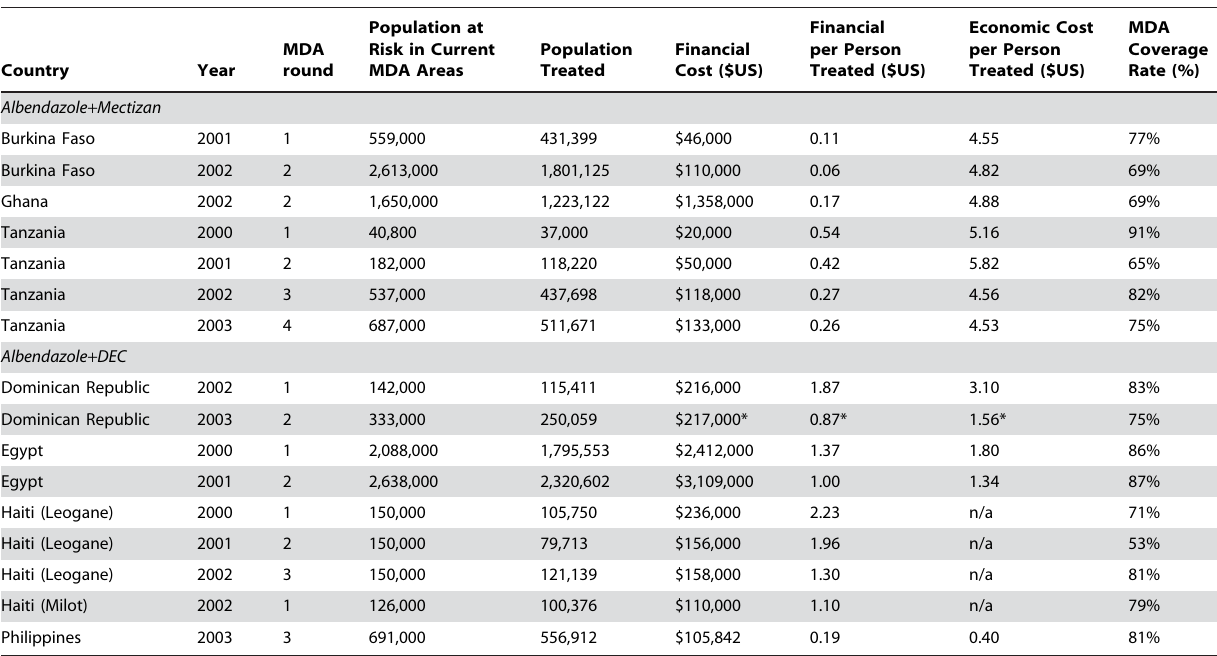
Table 4. Financial and Economic per Person Treated.